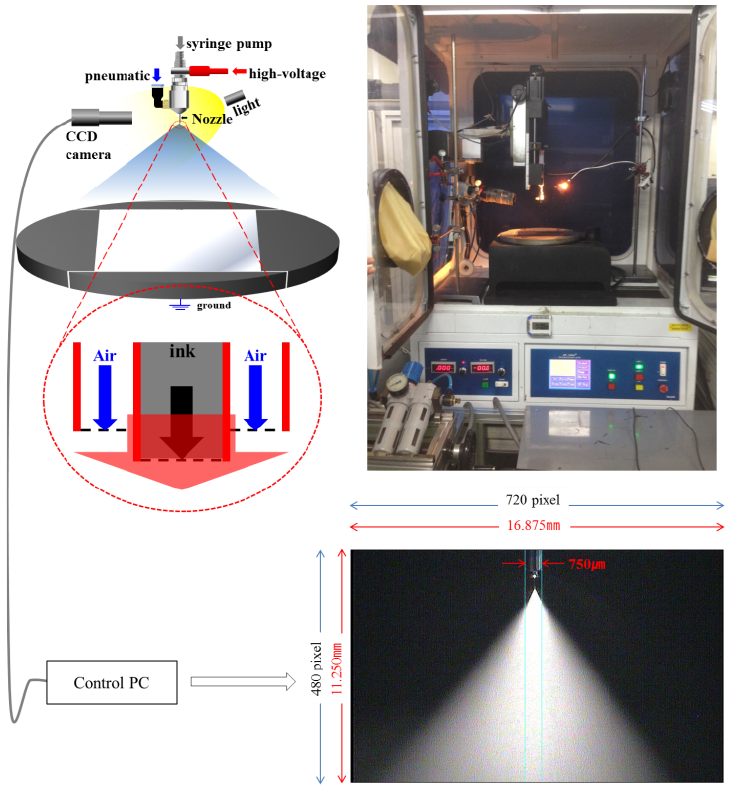
Figure 2. System for hybrid electrostatic atomization. Table 1. Process variables and the values used for the hybrid electrostatic atomization process. The electric field and pneumatic pressure are split while the other process variables are fixed.